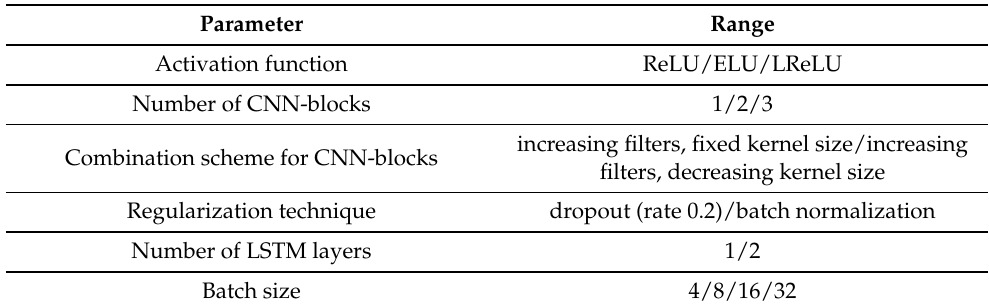
Table 1. Table of the parameters that were varied for the hyperparameter optimization, along with the range in which they were